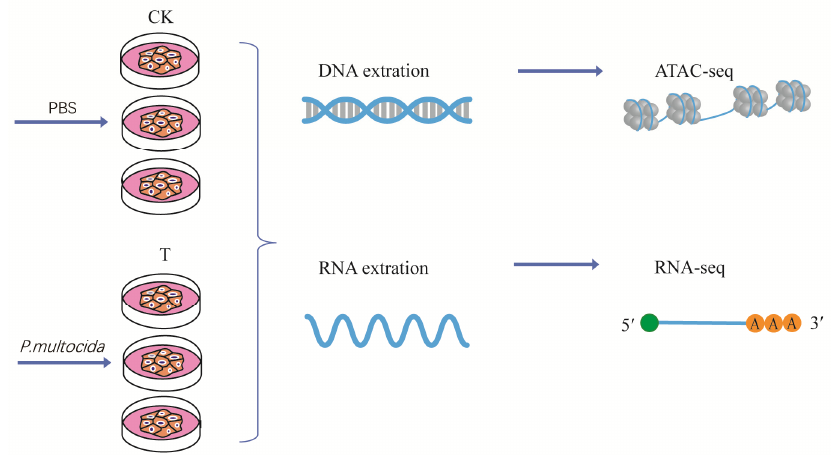
Figure 1. Overview of the experimental workflow. Three replicates of goat bronchial epithelial cells infected with P. multocida and three control replicates were collected for ATAC − seq. The same set of replicates was collected for RNA-seq.